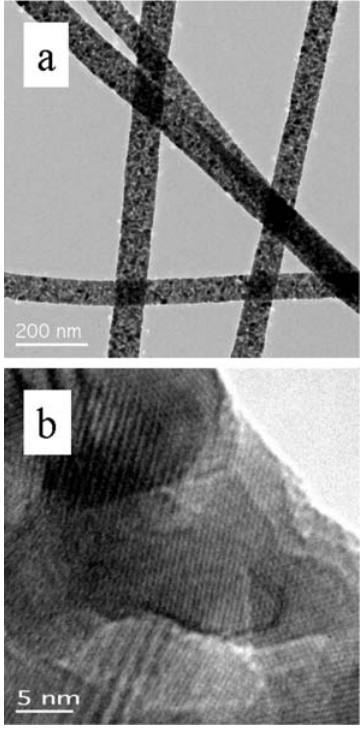
Figure 12. HRTEM image of calcined nanofibers (a) at lower resolution. (b) at higher